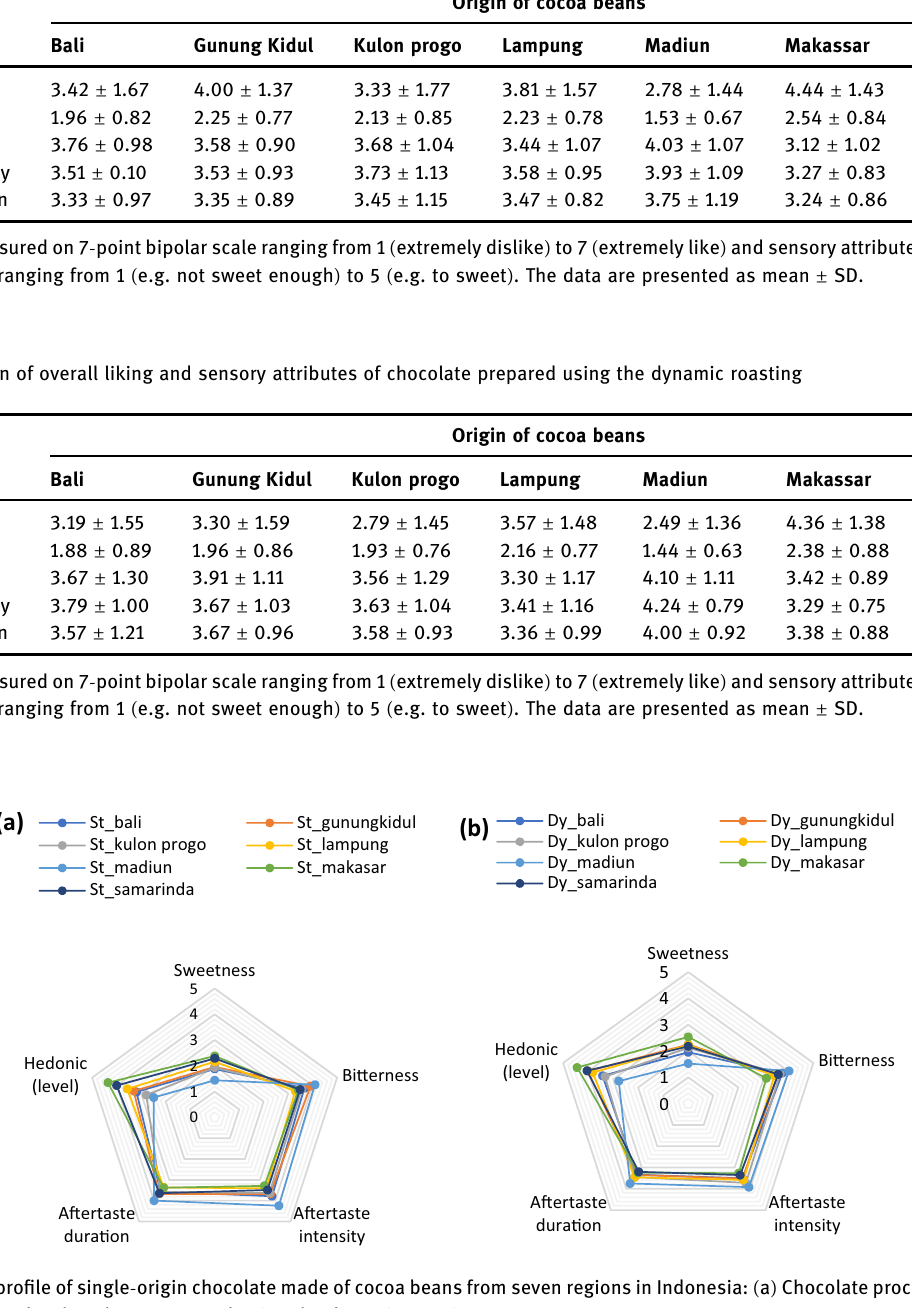
Table 4: Evaluation of overall liking and sensory attributes of chocolate prepared using the static roasting Attributes